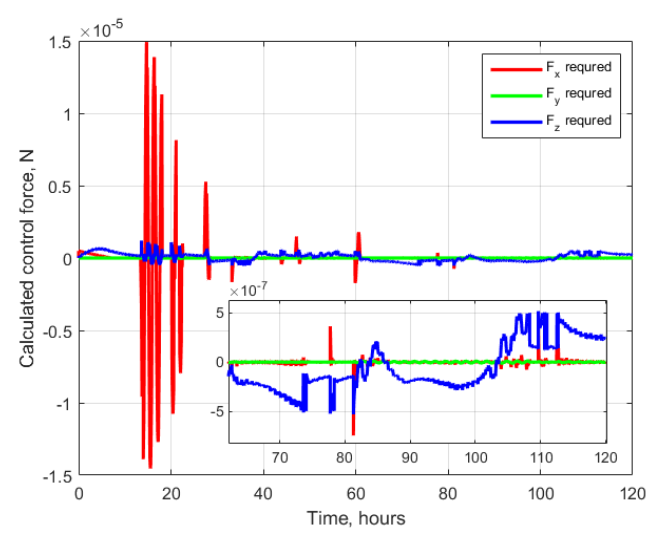
Figure 11. Calculated control values.